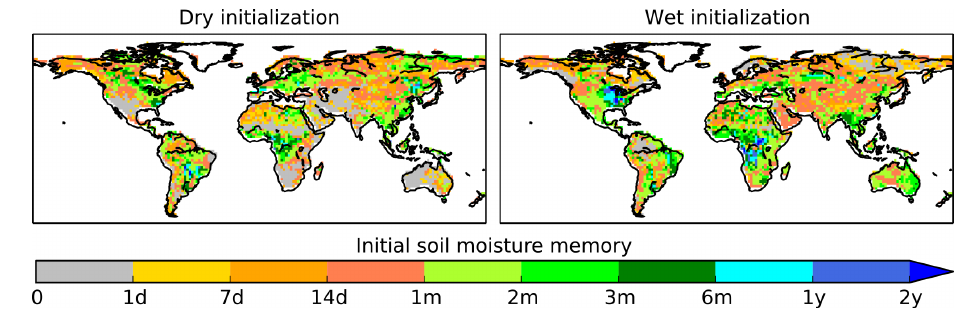
Figure 4. τ 0 for RootSM in dry (left) and wet (right) initialized simulations. The letters d, m, and y indicate days, months, and years,